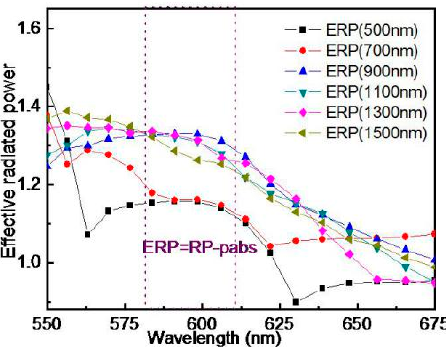
Figure 4. The effective radiated powers of different spacing of the Ag NPs by FDTD simulation.